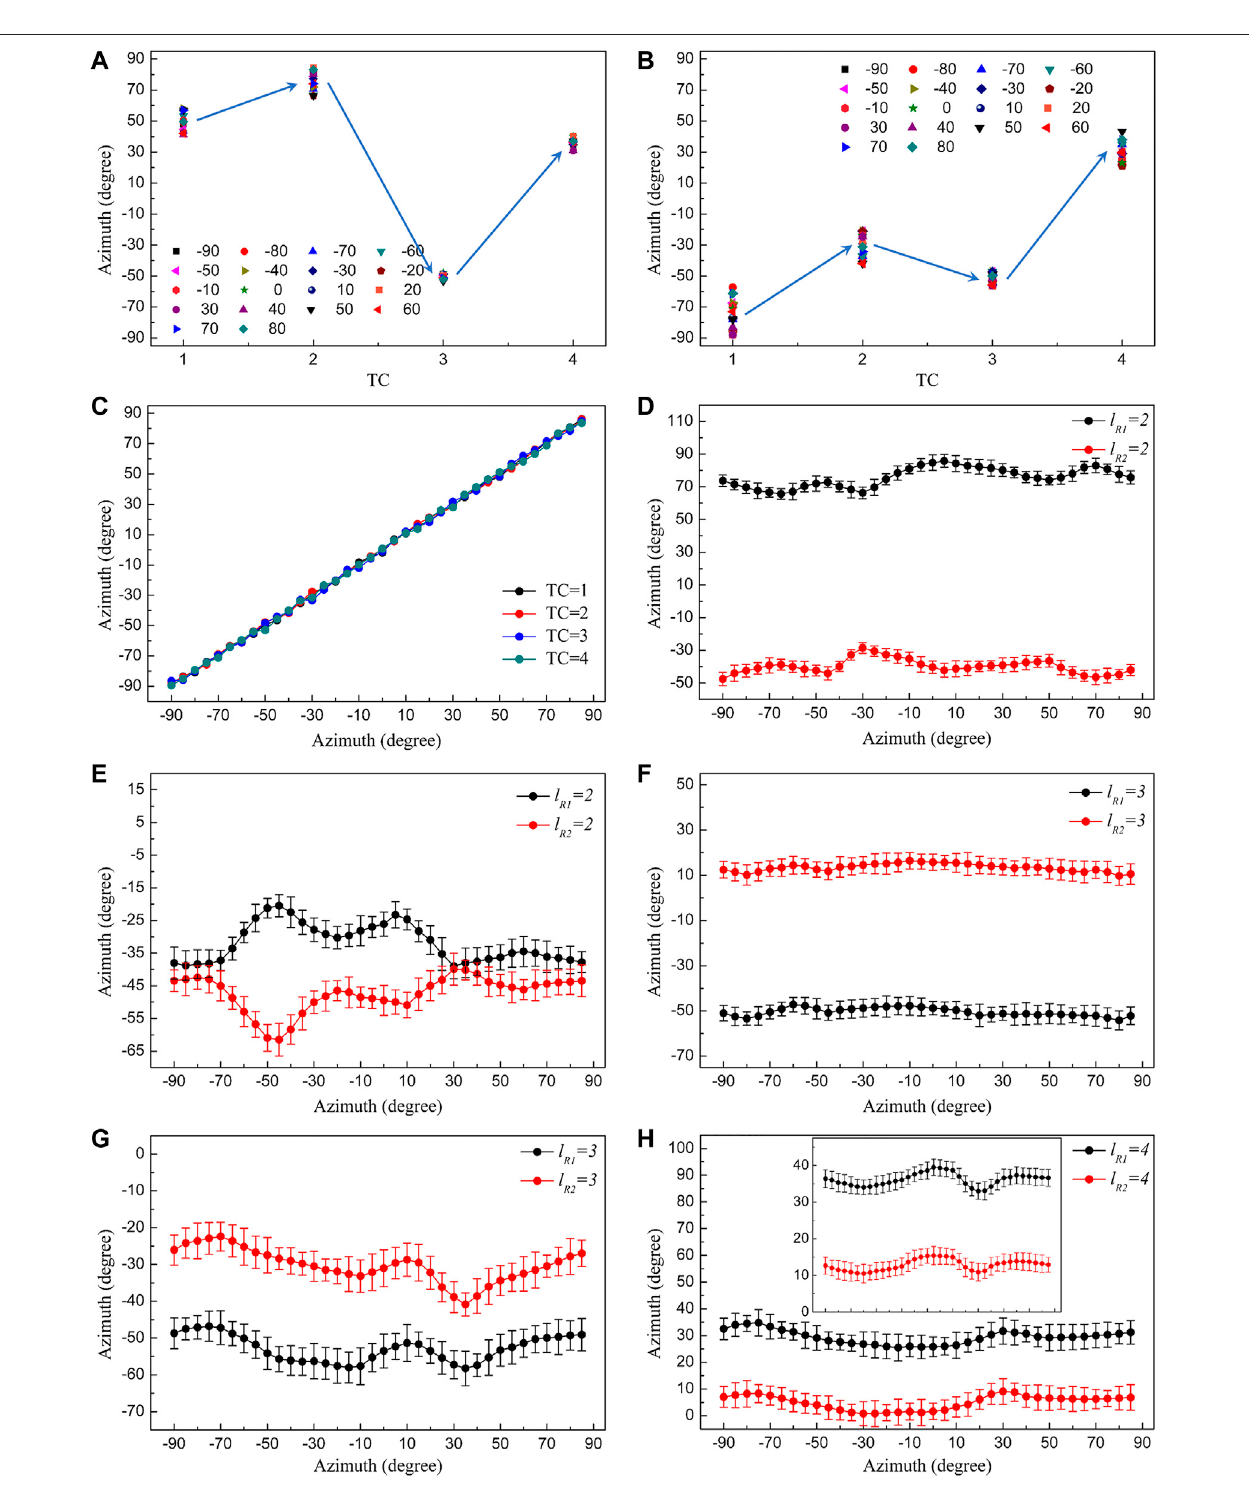
FIGURE 6 | OAM-controlled azimuth variation of the (A) − 1 st and (B) +1 st diffraction orders from OPHGs ( l R1 = 1 – 4) as TC of the vortex recording light increases from 1 to 4. (C) The azimuth ofthe zeroth-order diffraction light is not modulated by OPHGs, regardless ofthe value ofTC. When TC= 2, the azimuth ofthe (D) − 1 st and (E) +1 st order diffraction light from OPHGs ( l R1 = 2 and l R2 = 2) is controlled to vary symmetrically. With TC continuing to increase, the effect ofOAM is enhanced and the azimuth of the (F) − 1 st and (G) +1 st diffraction order from OPHGs ( l R1 = 3 and l R2 = 3) tends to vary synchronously. (H) Similar azimuth modulation of the +1 st diffraction order enabled by spin-orbit coupling when TC = 4. Inset: azimuth of the − 1 st order diffraction light from OPHGs ( l R1 = 4 and l R2 = 4).